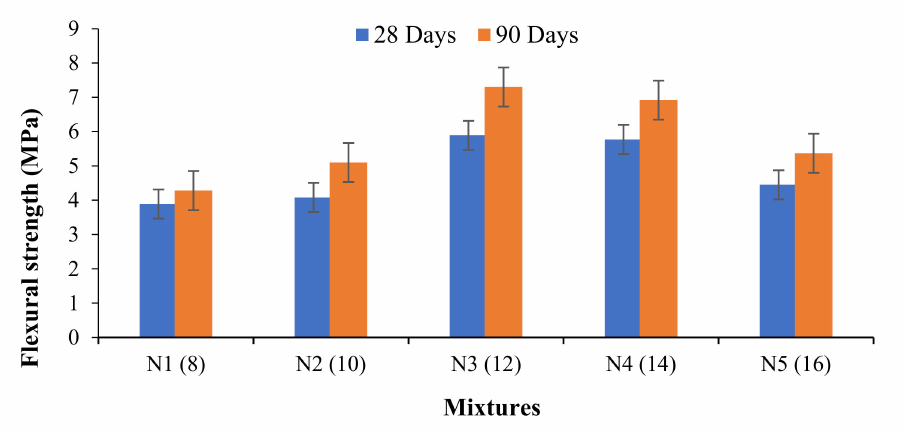
Figure 6. Flexural strength of